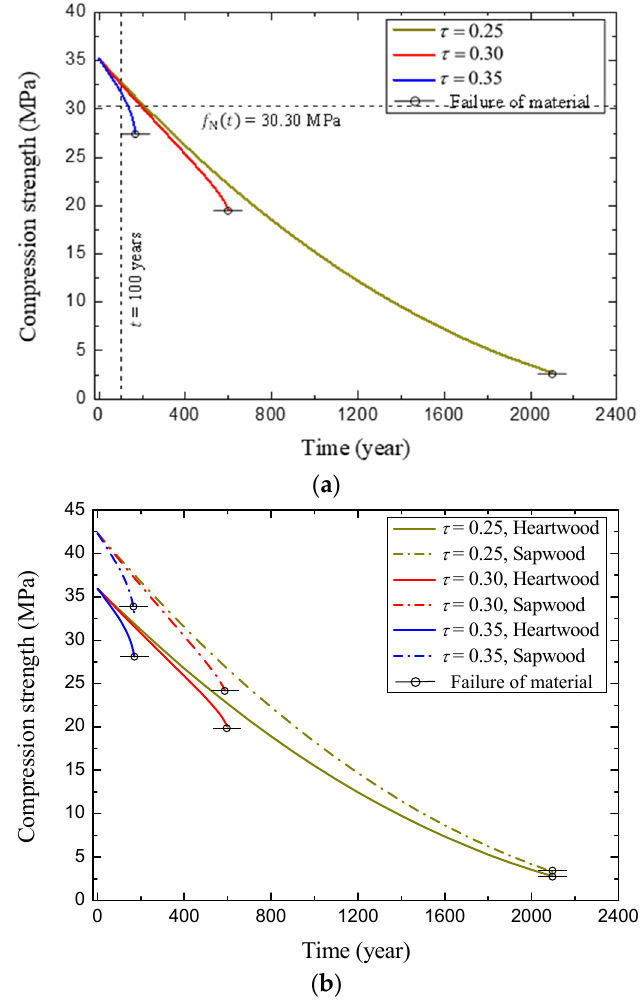
Figure 8. ( a ) Time-dependent model on the parallel-to-grain compressive strength. ( b ) Time-dependent model of the parallel-to-grain compressive strength of HW and SW.